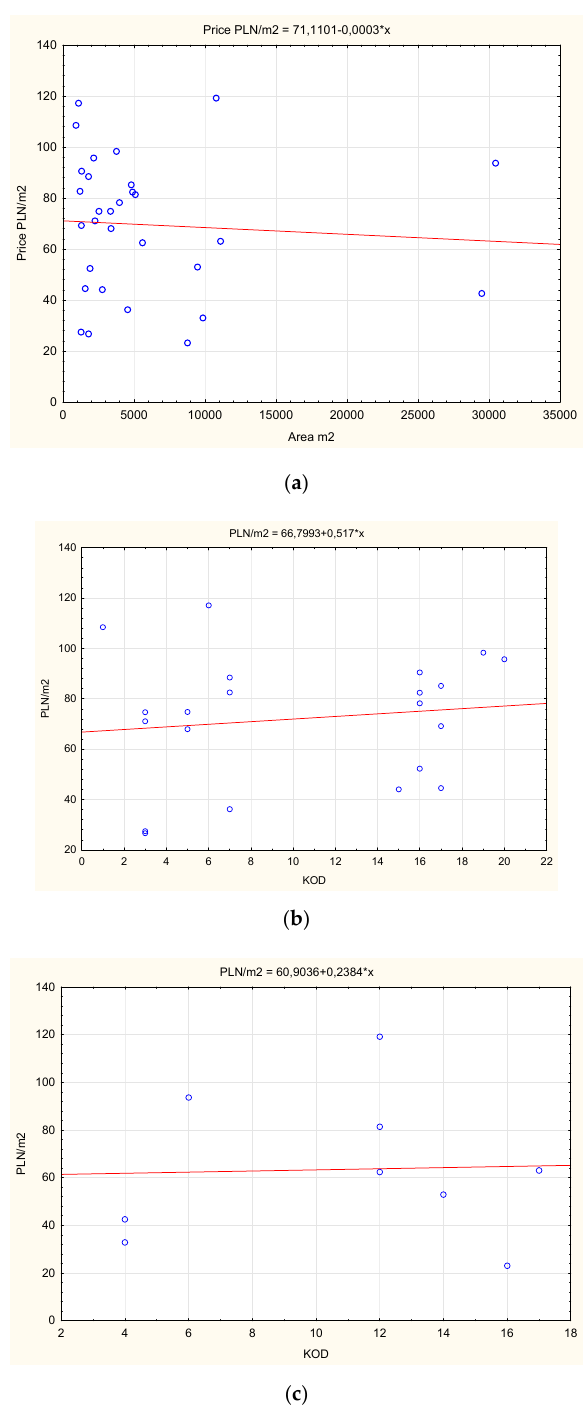
Figure 6. ( a ) Relationship between surface area and price in the examined real estate. ( b ) Relationship between plot area (up to 5000 m 2 ) and time interval. ( c ) Relationship between plot area (above 5000 m 2 ) and time interval. Source: own study. Legend: KOD—the time interval covering the number of months from real estate transactions to the time of the